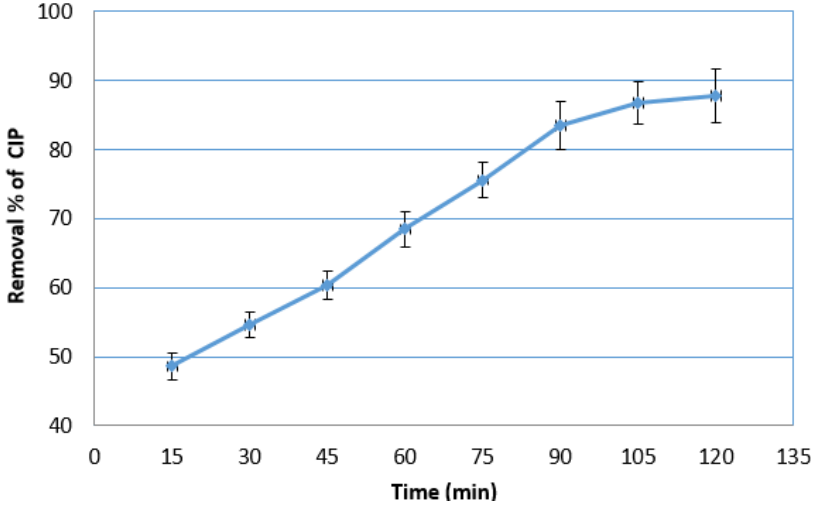
Figure 4. CIP removal percentage using net TiO 2 during testing under optimal operating conditions: initial concentration of CIP = 30 ppm, pH = 5, feed flow rate = 0.4 L/min.